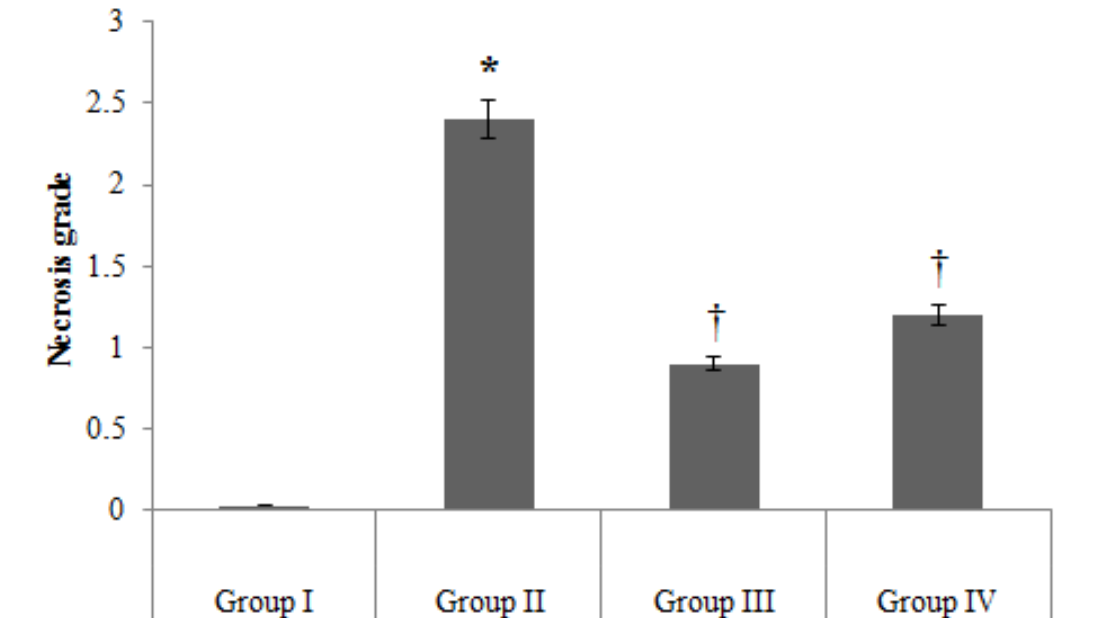
FIGURE 6 - Effects of sitagliptin on APAP-induced alterations on necrosis grade. Group I: normal control group; group II: APAP-treated group; group III: sitagliptin-treated group (10 mg/kg/day) 5 days before APAP administration; group IV: N -acetylcysteine-treated group (100 mg/kg orally). Data are expressed as mean ± SEM for n = 10. * : P < 0.05 compared to normal control group; †: P < 0.05 compared to APAP control group by one-way ANOVA test followed by post hoc